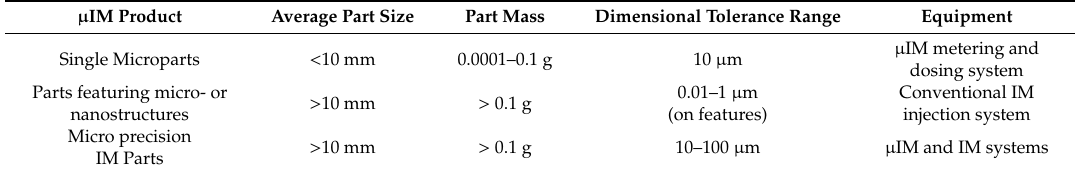
Table 1. Conventional product classification for micro-injection molding ( µ IM).